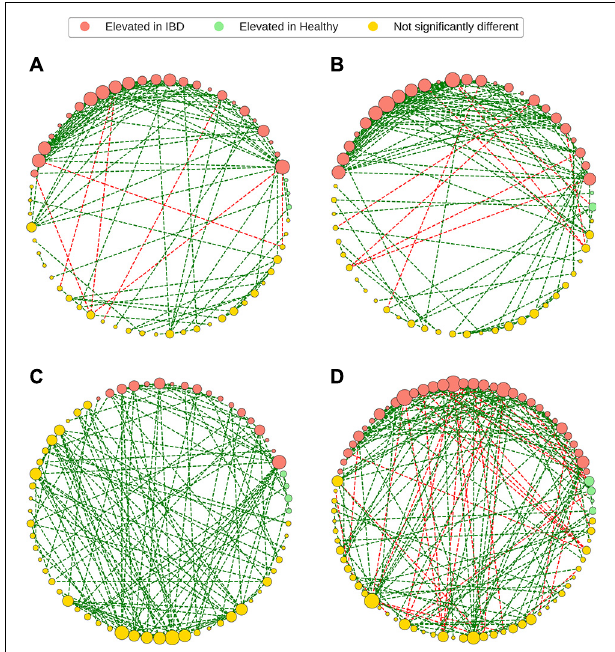
FIGURE 5 | Gut microbiome bacterial species association networks. The GGM framework was used to generate bacterial association networks from CLR-transformed relative abundances. The bacterial species (nodes) were colored based on the differential abundance analysis and the node sizes were based degree of each node within the network. Bacterial species that were elevated in IBD were still present, and in high degree, in the non-IBD and healthy networks. It was also noted that the most common constituents of the bacterial association networks were bacteria that were not significantly differentially abundant in IBD, relative to the healthy and non-IBD groups. Finally, the IBD networks demonstrated more negative edges when compared to the non-IBD and healthy groups. (A) IBD network, (B) non-IBD network, (C) Healthy-1 network, (D) Healthy-2